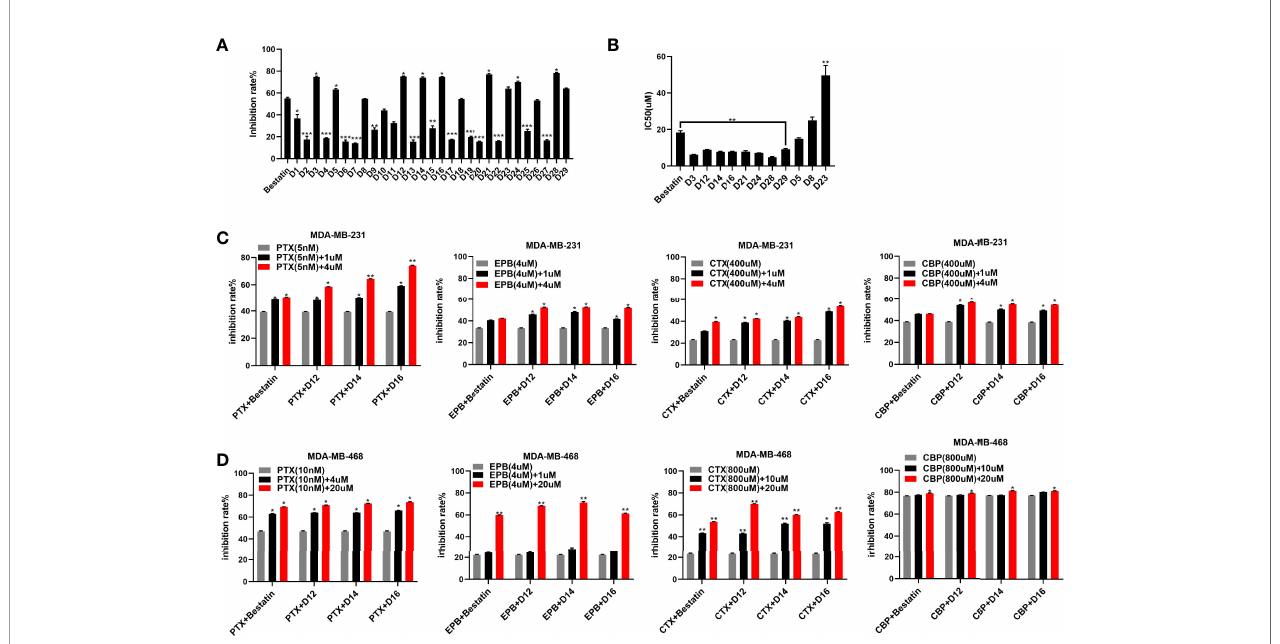
FIGURE 2 | Enzyme inhibitory and antiproliferative activities of the derived APN inhibitors. a: APN enzyme inhibitory rates (A) of the synthesized compounds; (B) IC 50 values of selected compounds; (C) antiproliferative activities of representative compounds in combination with chemotherapeutic drugs against MDA-MB-231 cells; (D) antiproliferative activities of representative compounds in combination with chemotherapeutic drugs against MDA-MB-468 cells; *P ≤ 0.05, **P ≤ 0.01, ***P ≤